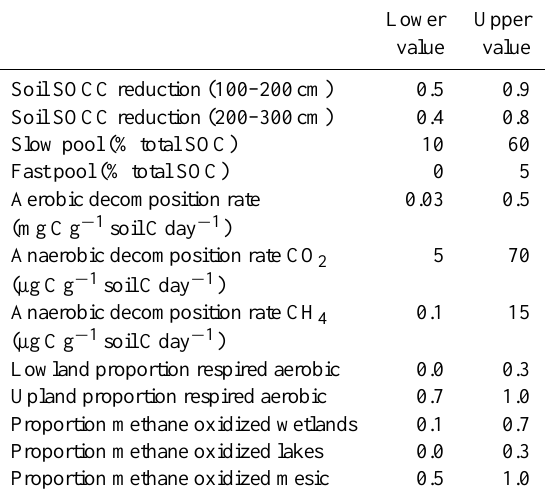
Table 1. Spread of values for simple modelling